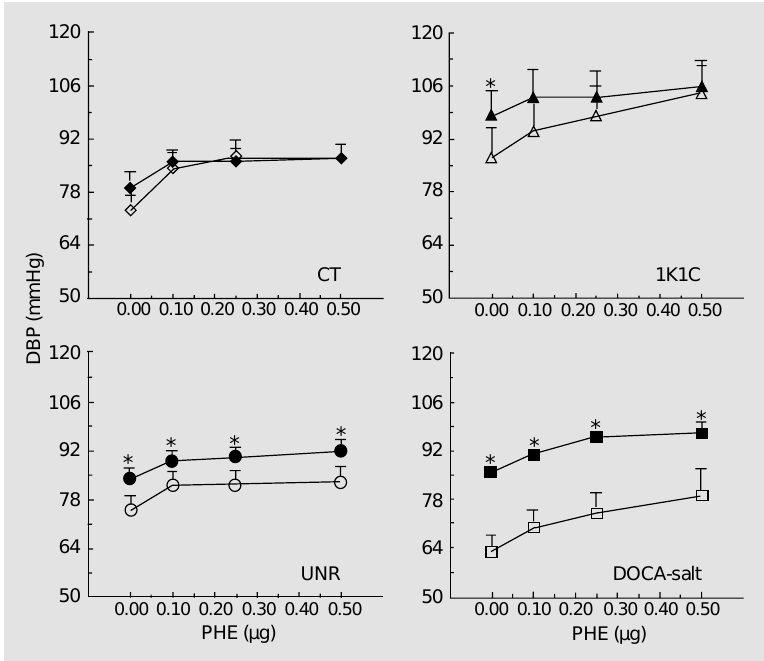
Figure 5. Changes in diastolic blood pressure (DBP) in response to increasing doses of phenylephrine (PHE) in normotensive (control, CT; uninephrectomized, UNR) and hypertensive (1K1C and DOCA-salt) rats before (open symbols) and after (closed symbols) treatment with 0.18 µg/kg ouabain. Points represent the means ± SEM. *P<0.05 compared to before ouabain treatment